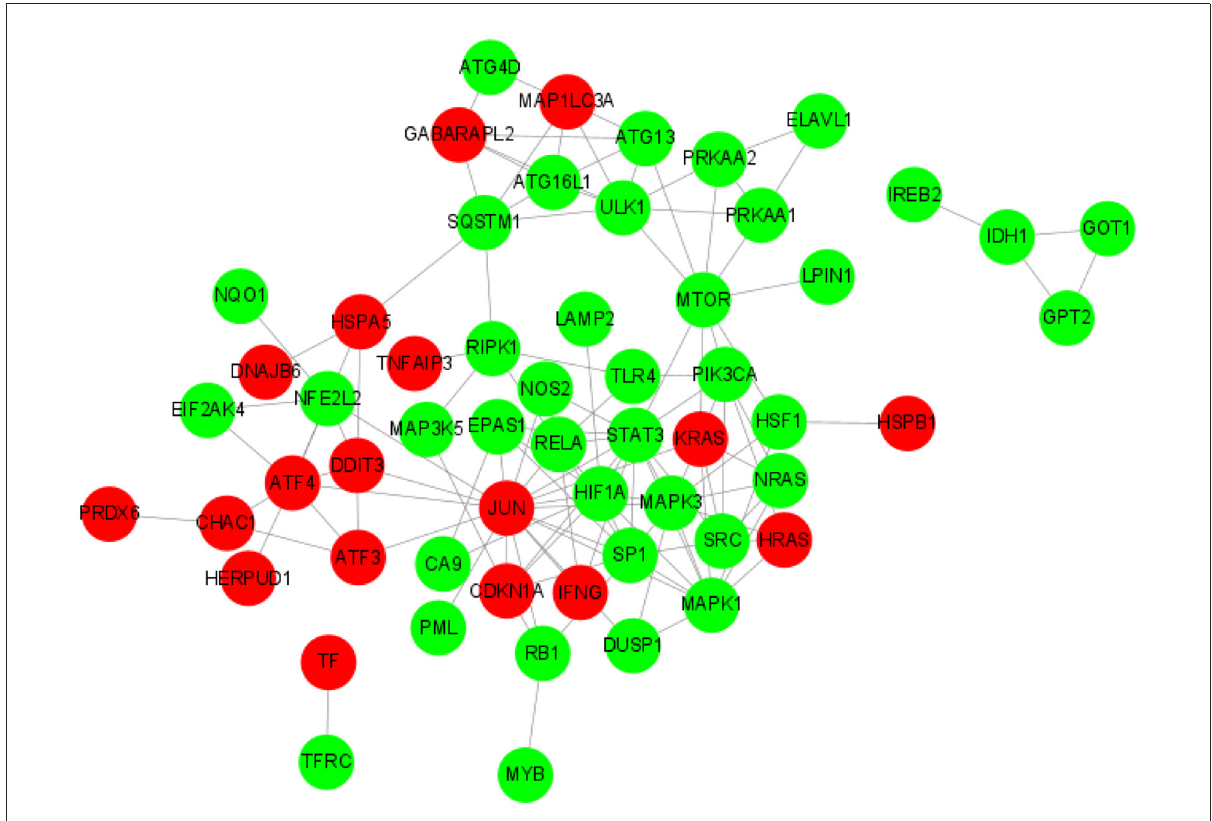
FIGURE6 PPI network of